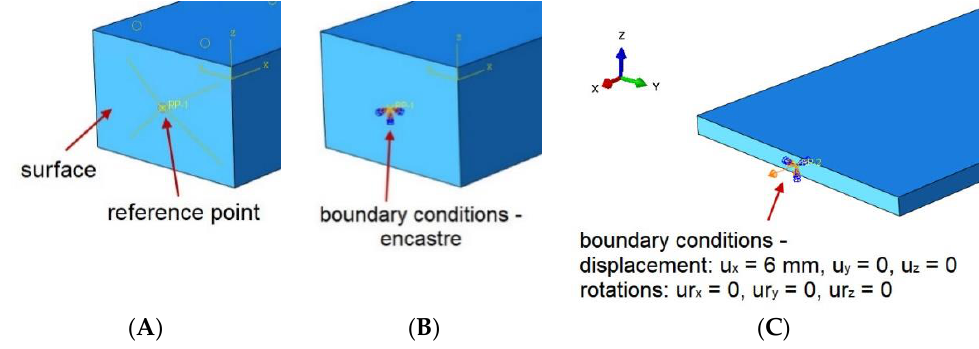
Figure 5. Boundary conditions. ( A ) Reference point connected to the surface; ( B ) Encastre boundary conditions and ( C ) Displacement boundary conditions.